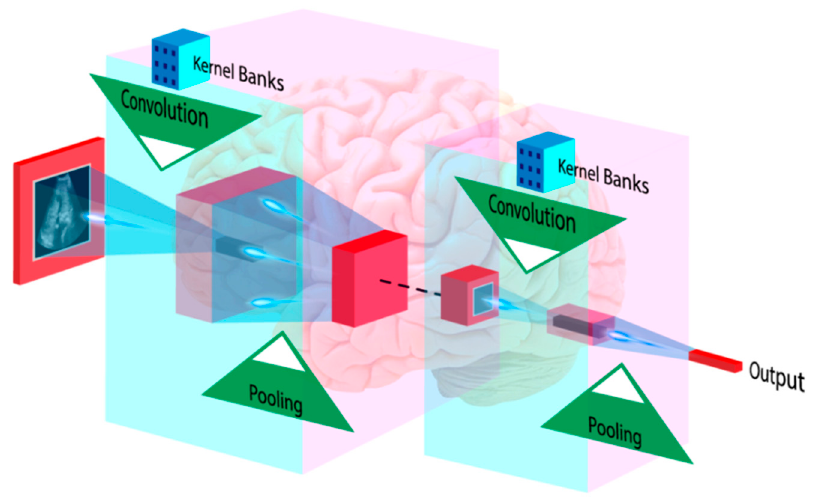
Figure 7. CNN-based medical image analysis architecture. (Courtesy of AtheroPoint, Roseville, CA, USA permission granted).